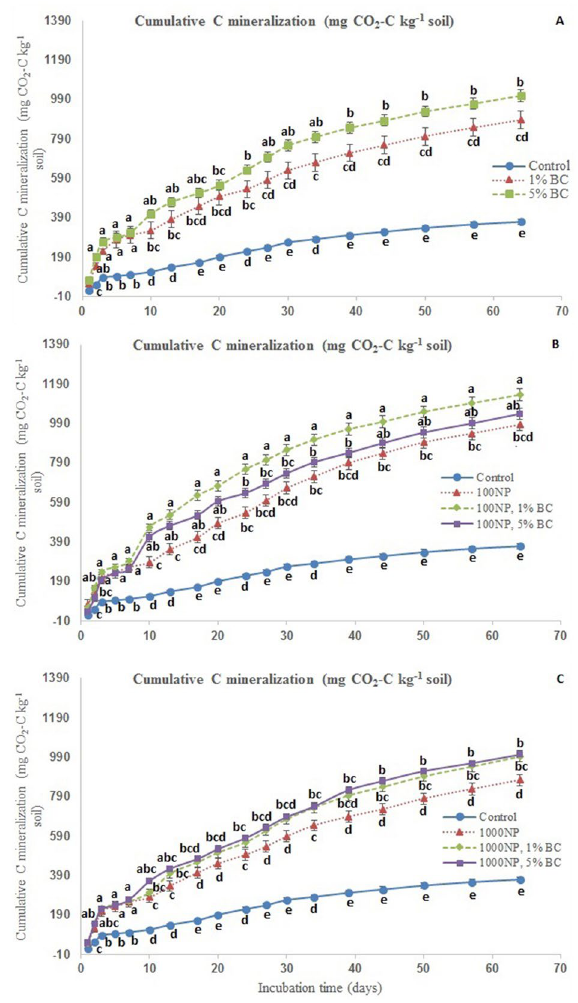
Figure 3. Cumulative carbon mineralization (mg CO 2 -C kg −1 soil) as affected by zinc oxide (nZnO) and rice-straw derived biochar over 64 days of incubation. Cumulative C mineralization in different BC, nZnO and BC + nZnO treatments for a given date have been plotted in different panels (e.g. panels A , C , E ) for the purpose of simplification. Different small letters on treatment points across three panels represent post-hoc HSD difference at 95% confidence